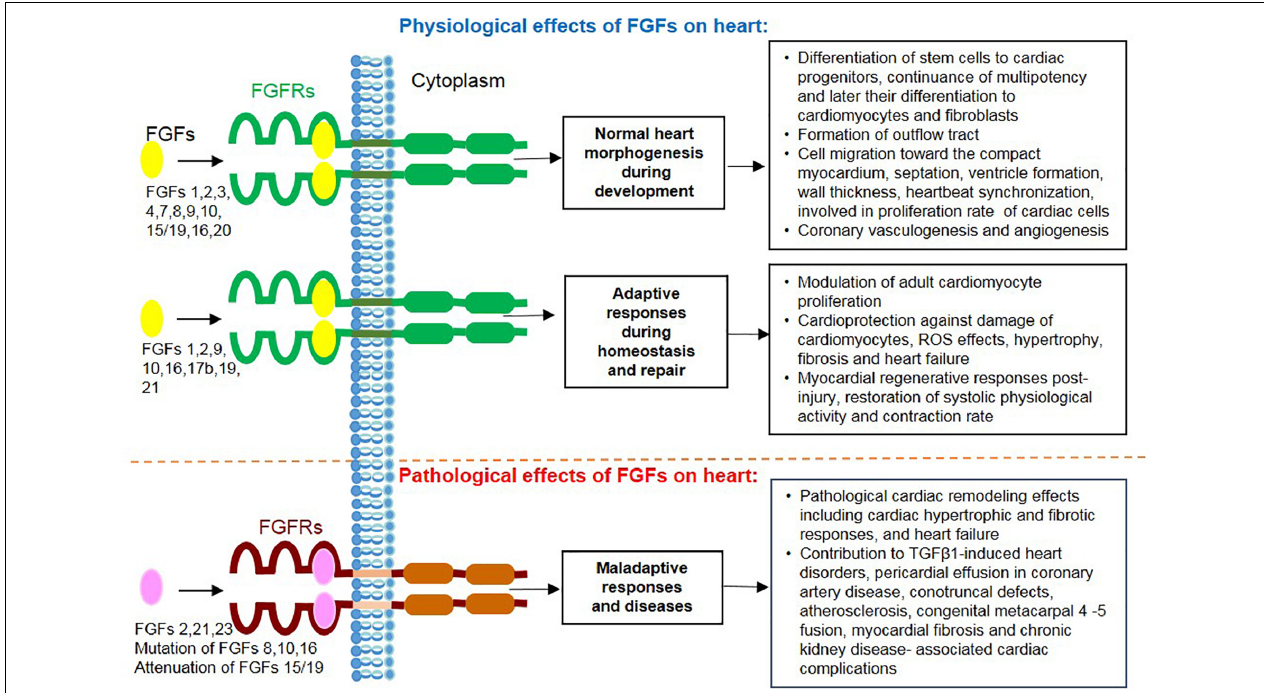
FIGURE 3 | Overview of actions mediated by secreted FGF ligands on the heart including physiological effects during cardiac development, homeostasis and repair together with their pathological and maladaptive effects during heart